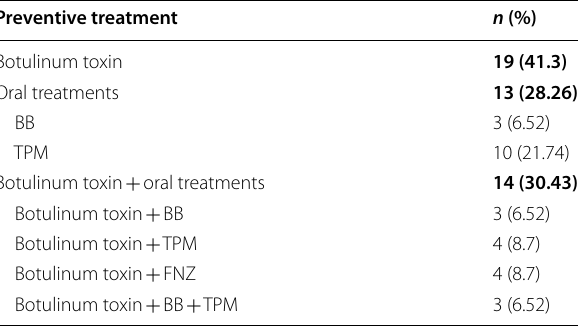
Table 1 Preventive treatments scheme ( n treatment‑naïve)